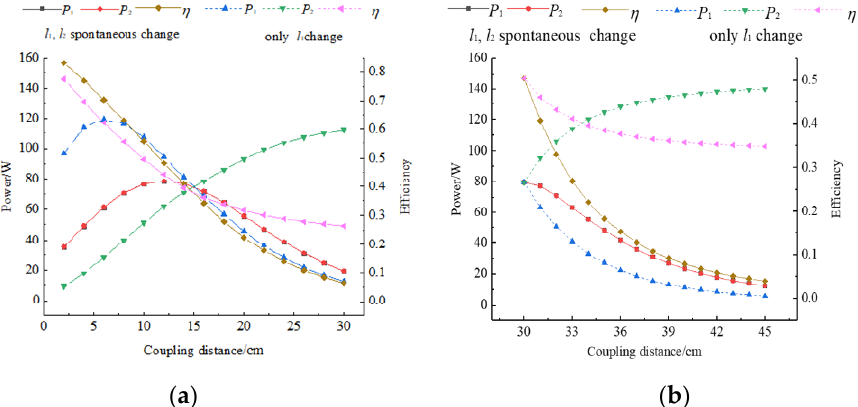
Figure 8. The relationship between the system parameters and the coupling distance of the same side and the same axis. ( a ) Different axis the same side. ( b ) Different axis coplanar. and the same axis. ( a ) Different axis the same side. ( b ) Different axis